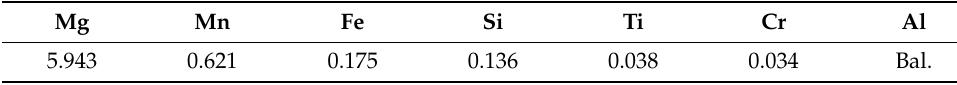
Table 1. Measured chemical composition of 5A06 aluminum (wt%).